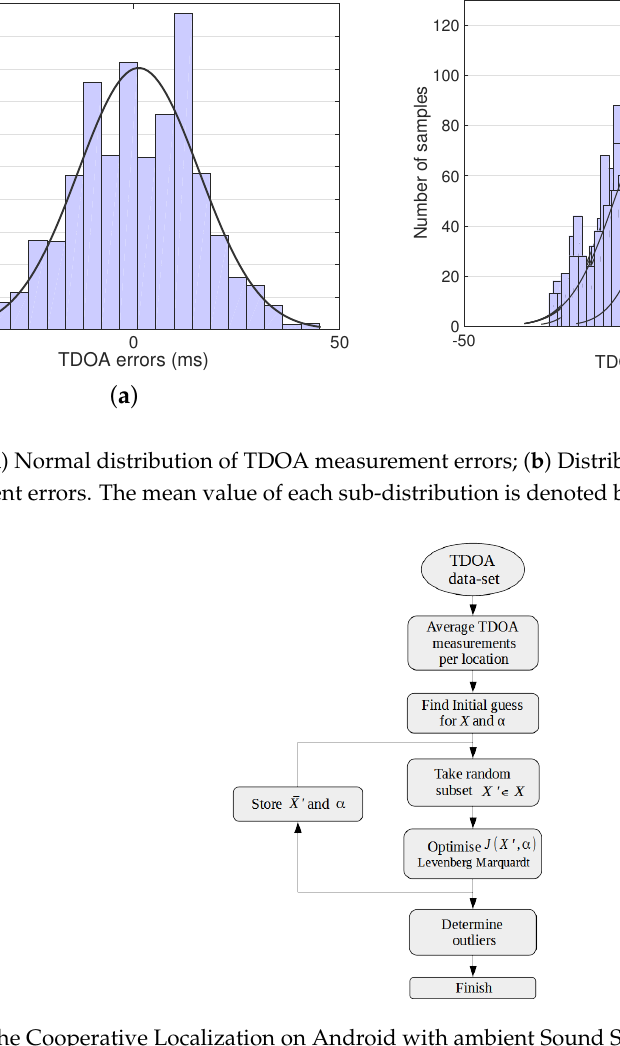
Figure 3. The Cooperative Localization on Android with ambient Sound Sources (CLASS)